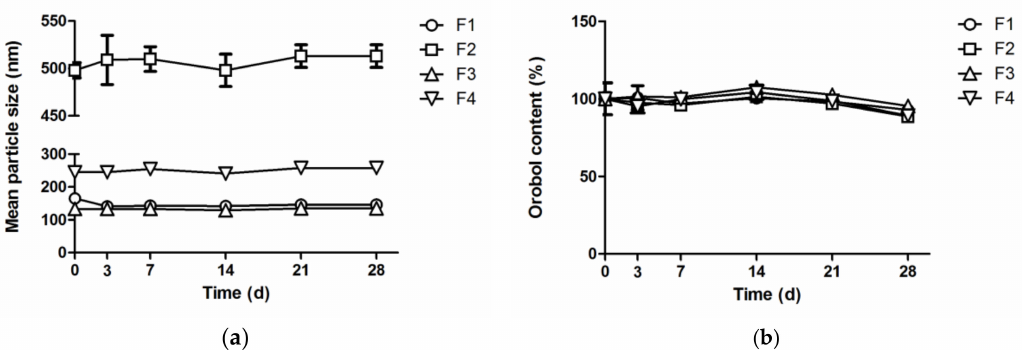
Figure 5. ( a ) The change of the mean particle size and ( b ) orobol content (% of initial day) in orobol-loaded formulations at room temperature under